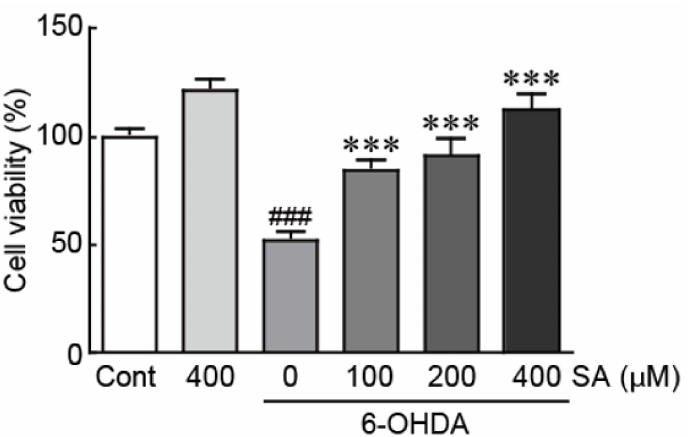
Figure 2. SA rescues SH-SY5Y neuroblastoma cells from 6-OHDA-induced neurotoxicity. The cell viability was measured via the MTT assay using cells treated with 6-OHDA for 24 h with or without 100, 200, or 400 µ M of SA pretreatment for 24 h. The columns and error bars represent the mean ± standard error of the mean (SEM) from three independent experiments. Significance was determined via a one-way ANOVA coupled with Bonferroni’s post hoc test. ### p < 0.001 vs. control group. *** p < 0.001 vs. 6-OHDA-only group. Cont, control; SA, sinapic acid; 6-OHDA,